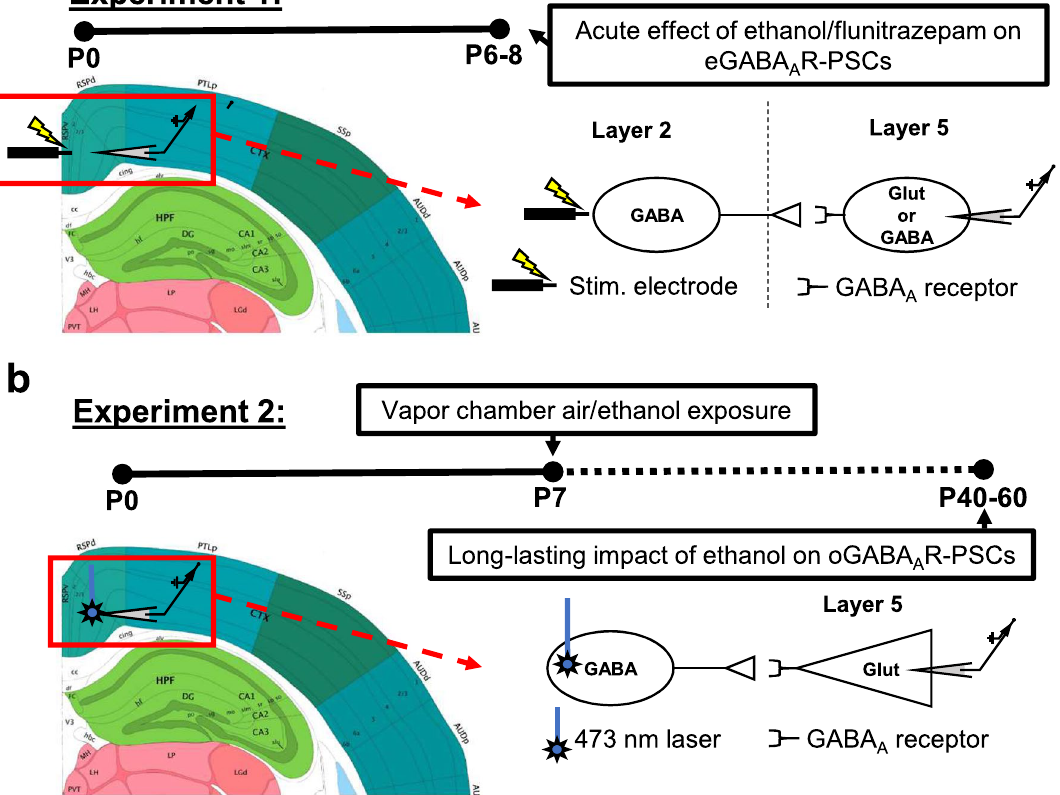
Figure 1. Overview of electrode placement and timeline for the two experiments performed. ( a ) Electrode placement and timeline for Experiment 1. The acute effects of ethanol and flunitrazepam on GABA A receptor mediated PSCs were measured in layer V pyramidal neurons and INs of the RSC. To electrically evoke GABA A - PSCs, a bipolar stimulating electrode was placed on the border of layers I/II. ( b ) Electrode placement, laser stimulation location, and timeline for Experiment 2. The long-term effects of P7 ethanol vapor chamber exposure were measured at P40–60. PV-INs expressing channel rhodopsin-2/tdTomato were stimulated with a 473 nm laser using a 40 × objective lens in layer V of the RSC. Optically evoked IPSCs were recorded in layer V pyramidal neurons. Atlas images were adapted from the Allen Brain Coronal Atlas (©2015 Allen Institute for Brain Science. Allen Brain Atlas API. Available from: htttp://brain-map.org/api/index.html) 80 . Image credit: Allen